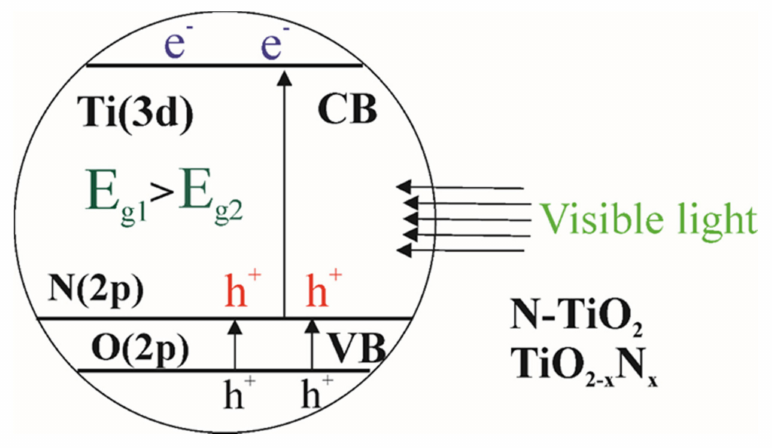
Figure 3. Changes in the band gap of TiO 2 upon doping with nitrogen